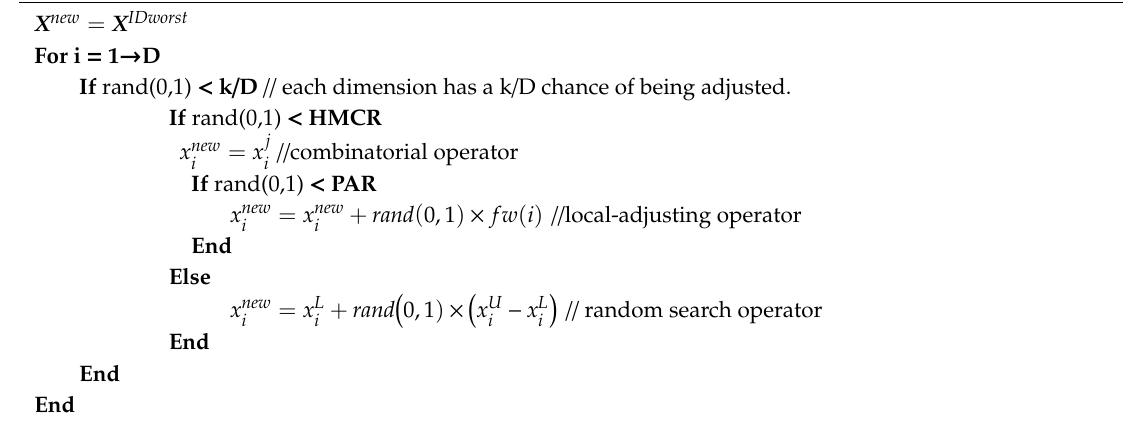
Algorithm 2. The Pseudocode for improvising new harmony for the take-k s X new = X IDworst For i = 1 →